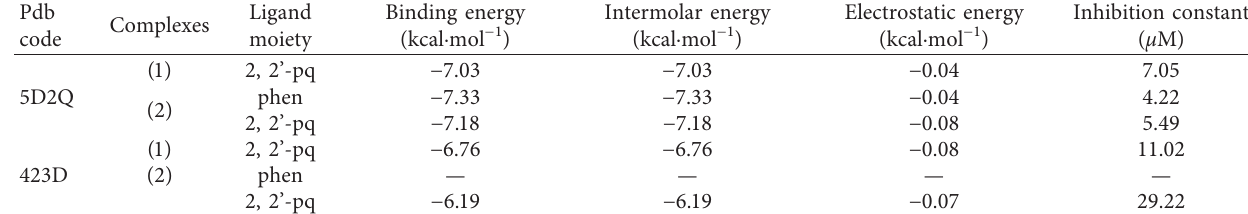
Table 8: Molecular docking studies for 1 and 2 with the sequence (TCATAAATGTATCTAAGTAG) (ACCGACGTCGGT) 2 (pdb code: 423D).